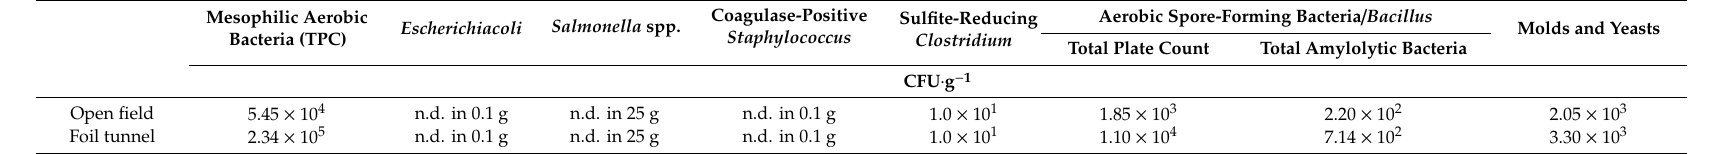
Table 9. Quantitative microbial contamination of air-dried